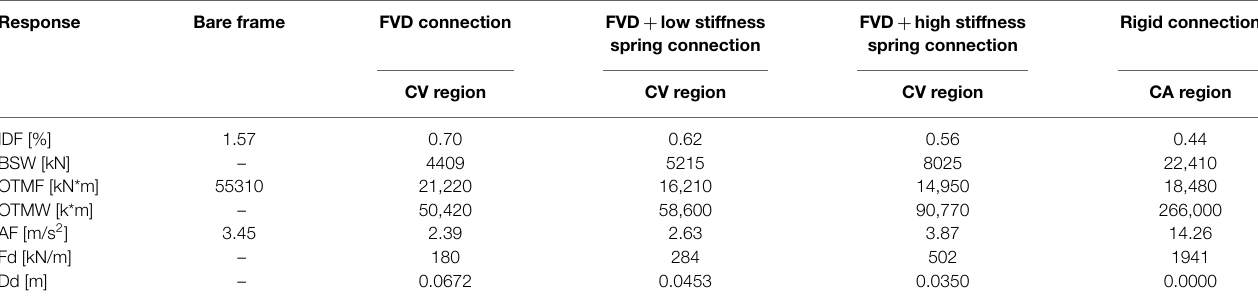
TABLE 1 | Responses of interest using the various connection options